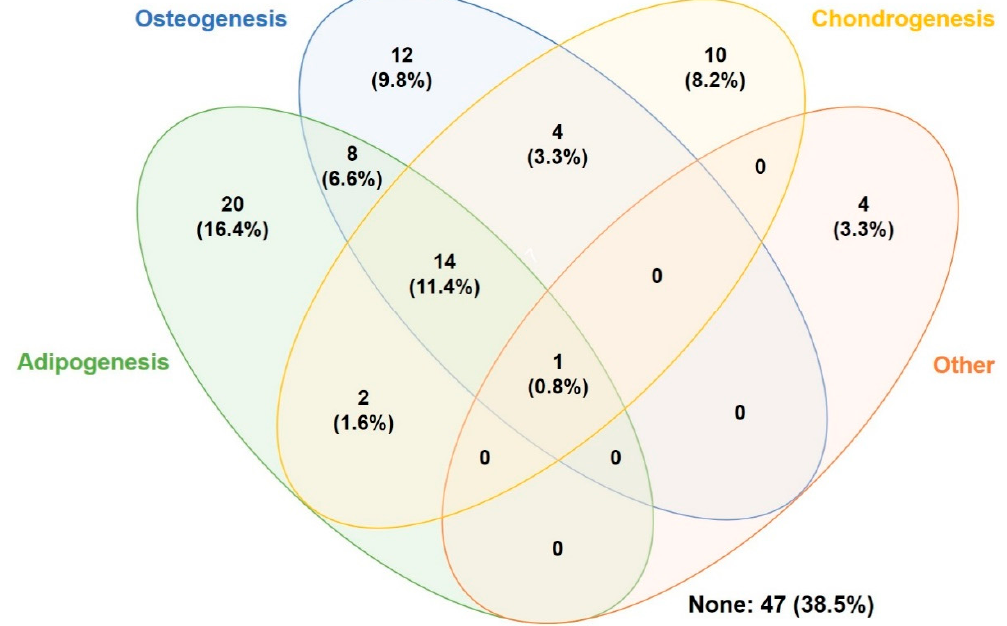
Figure 3. Venn diagram of differentiation pathways studied. Results given as percentage out of 122 total papers.